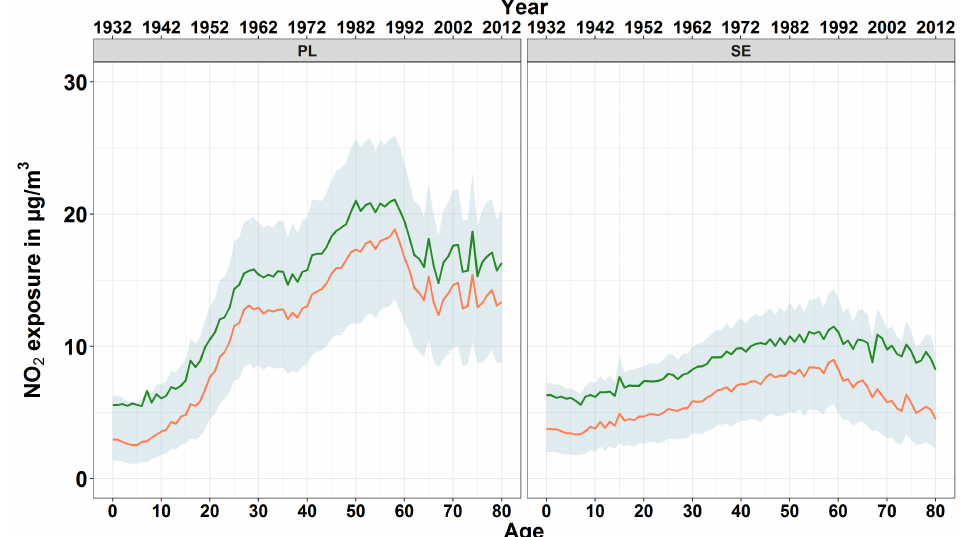
Figure 11. Temporal course of the lifelong exposure to NO 2 for an 80-year-old male from Poland and Sweden. The green line, red line and grey ribbon represent the mean, median and range of 25th to 75th percentile of the exposure